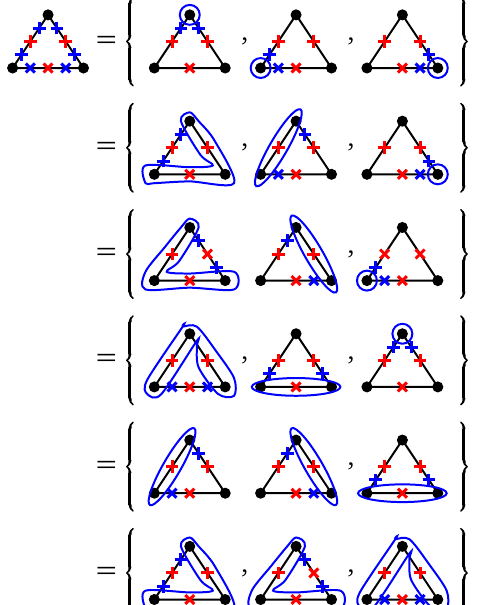
Figure 7: Higher codimension intersections of the facets outside S graphically obtained by considering a set of k < n marks the graph G in such a way that they do not share any marking. The red marking , while the blue one indicates the one introduced by a subgraph. All but the last are in common with the cosmological polytope analysis — for the full cosmological polytope, the last set can appear in a triangulation through more than one subsets of ) the locus C ( P G